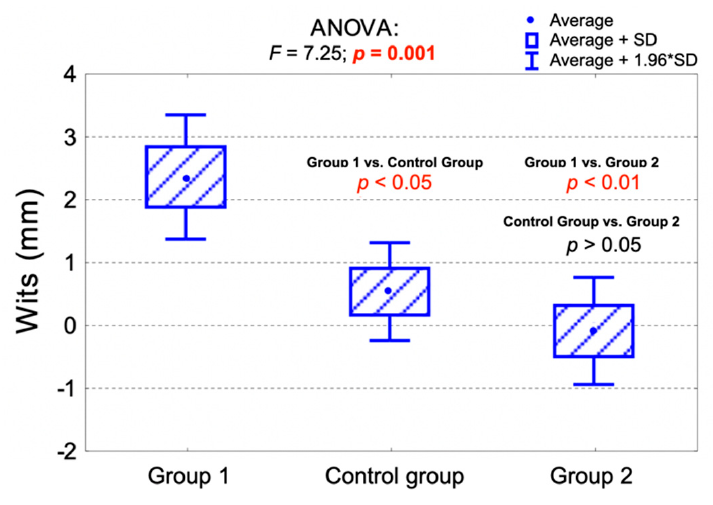
Figure 2. Comparison of the average Wits values among the examined groups and the results of the analysis of variance (ANOVA).